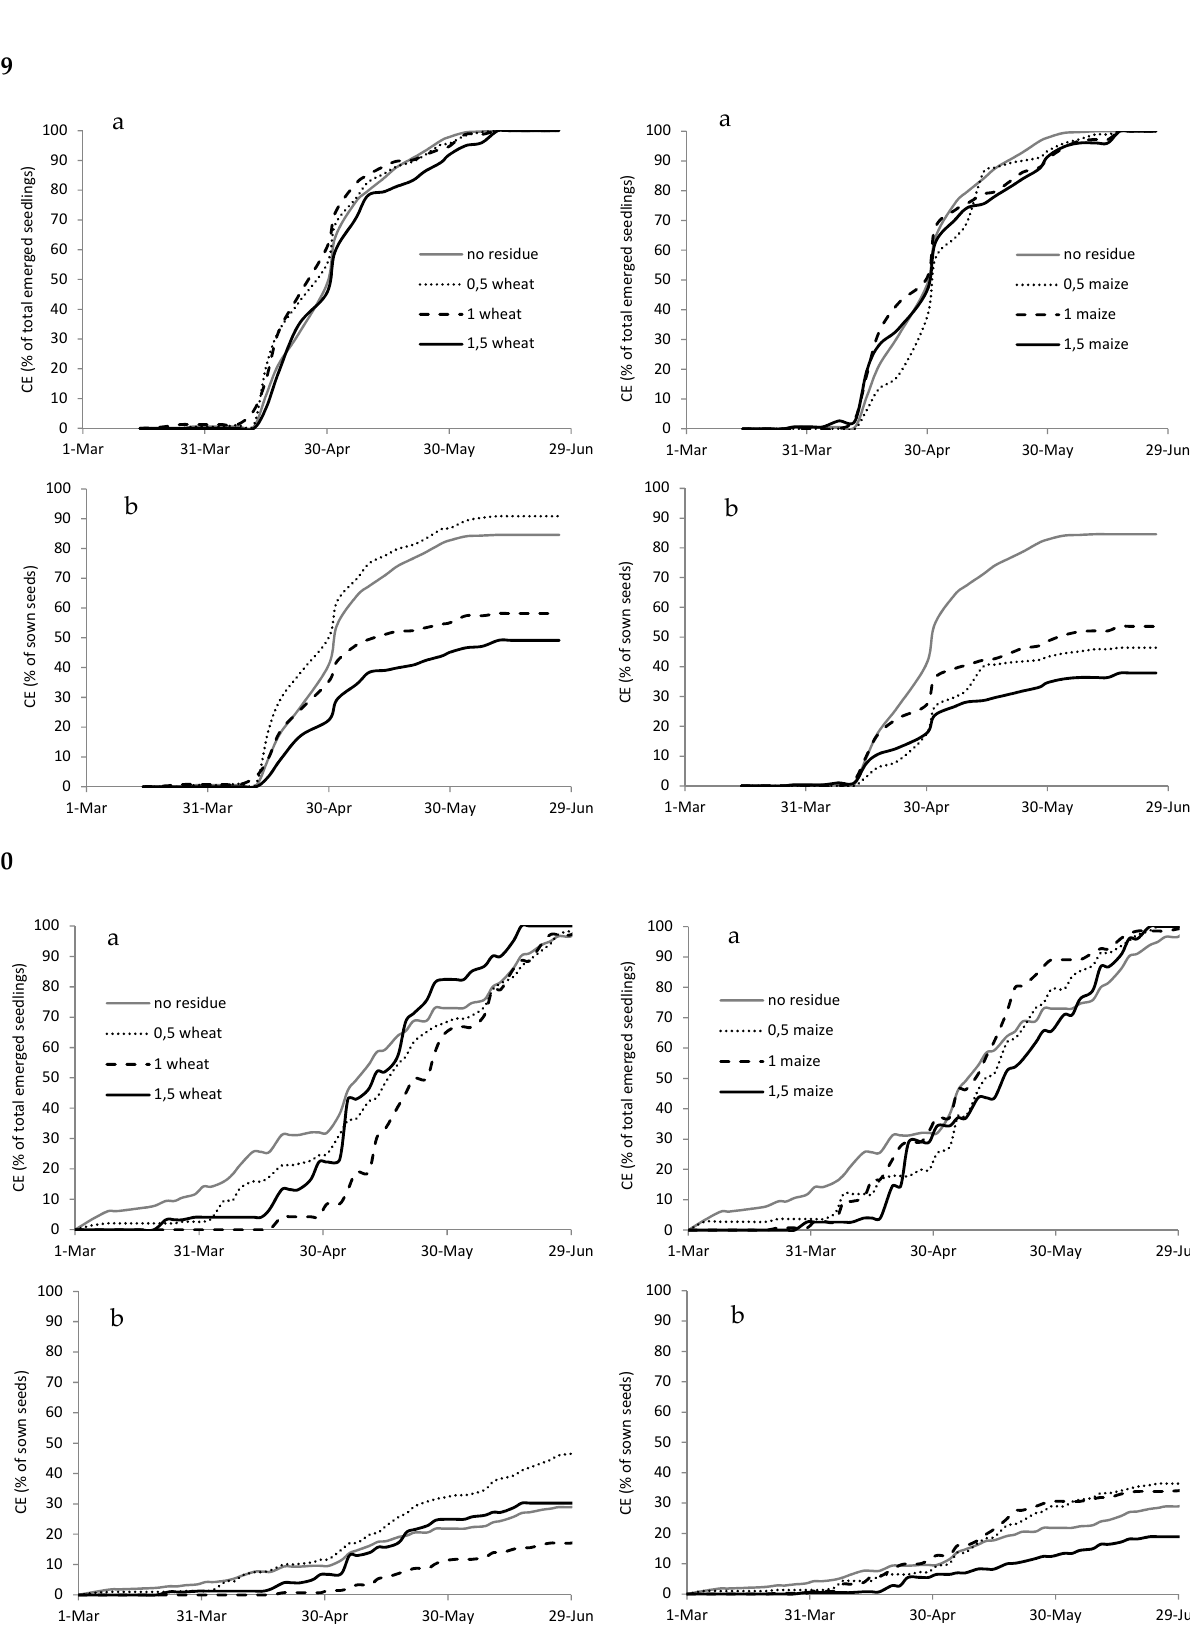
Figure A5. Cumulated emergence (CE) expressed as percentage of total emerged seedlings ( a ) and as percentage of sown seeds ( b ) of Echinochloa crus-galli in 2019 and 2020 with different types (wheat on the left and maize on the right) and amounts of crop residues.